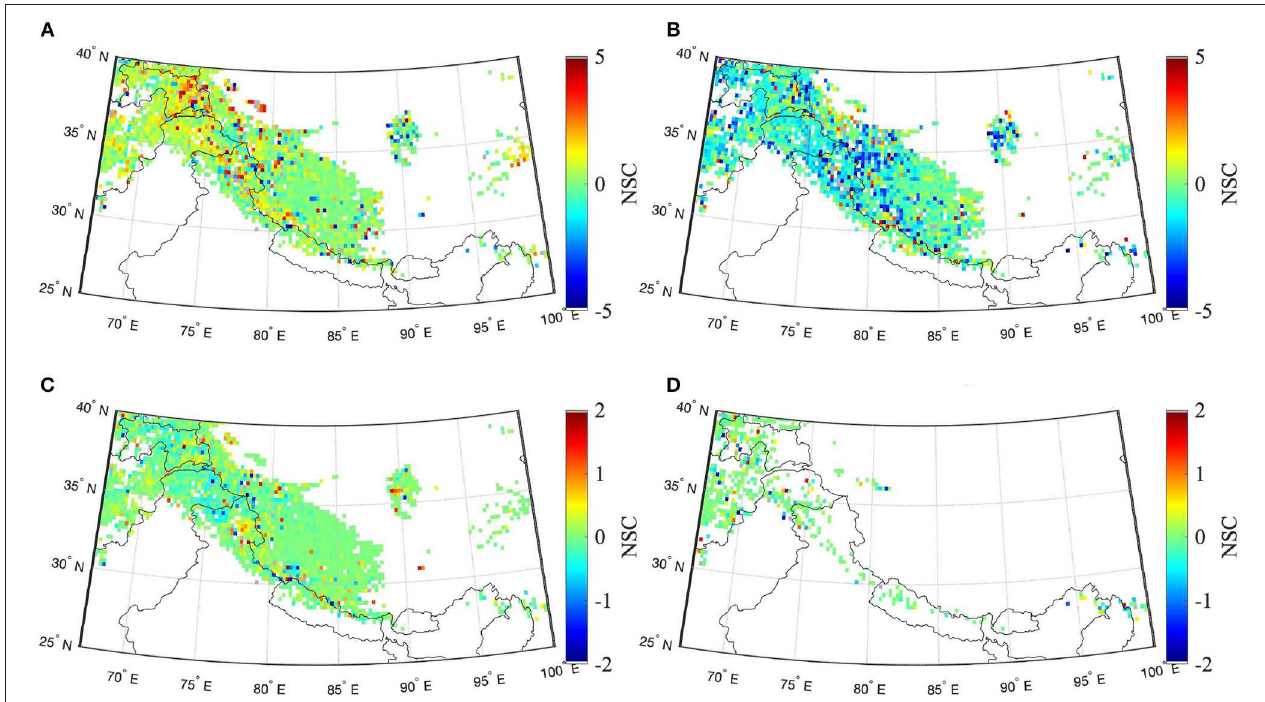
FIGURE 8 | Same as Figure 7 except using ECMWF+CHIRPS-2 as the precipitation boundary conditions to Noah-MP. White regions represent the areas that were either not snow-covered or where snow coverage in time was insufficient for SVM training. (A) Snow density [kg/m 3 ], (B) snow temp. (top layer) [K], (C) snow water equivalent [m], and (D) snow liq. water content [mm].